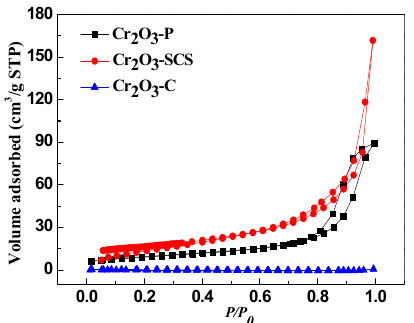
Figure 4. N 2 adsorption isotherms of Cr 2 O 3 catalysts prepared by different methods. Table 2. Textural parameters of Cr 2 O 3 prepared by different methods.